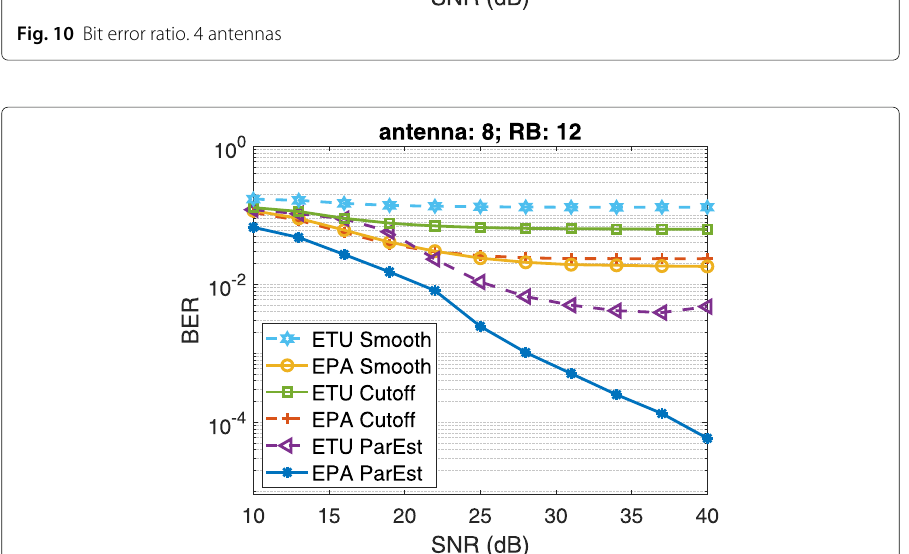
Fig. 11 Bit error ratio. 8